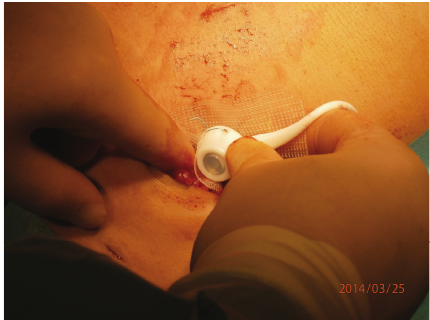
Figure 2: Placement of port and mesh into subcutaneous pocket.